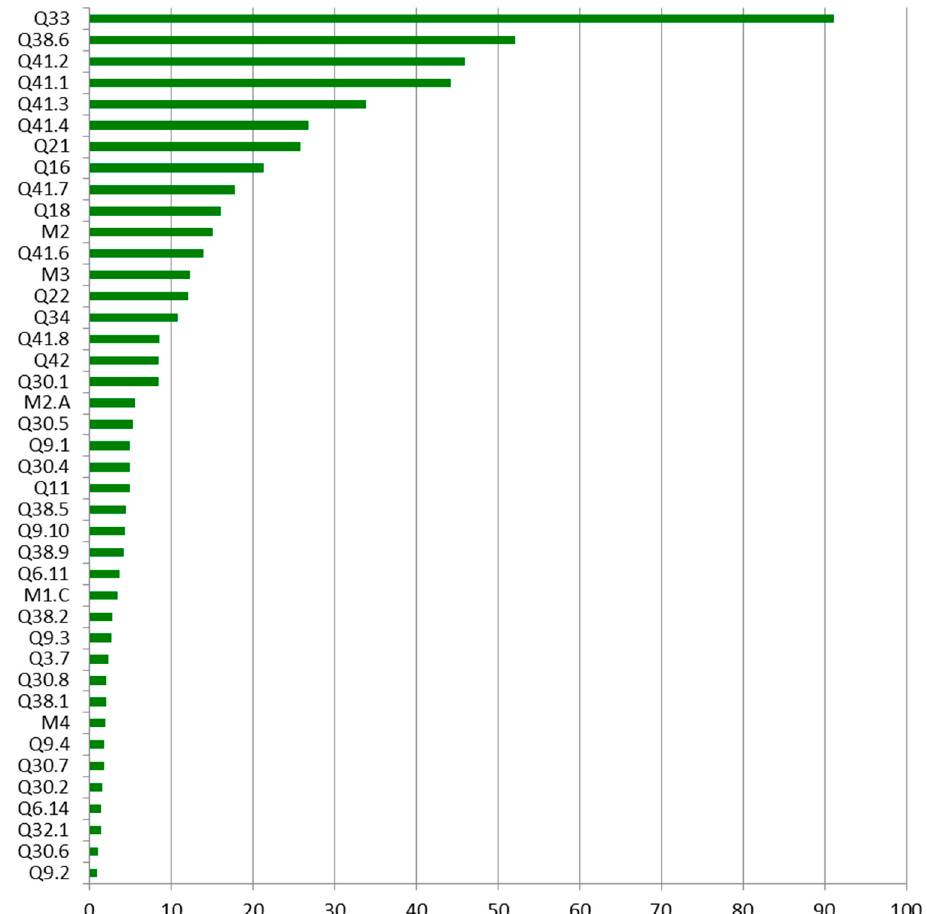
Figure 3. Variable importance.